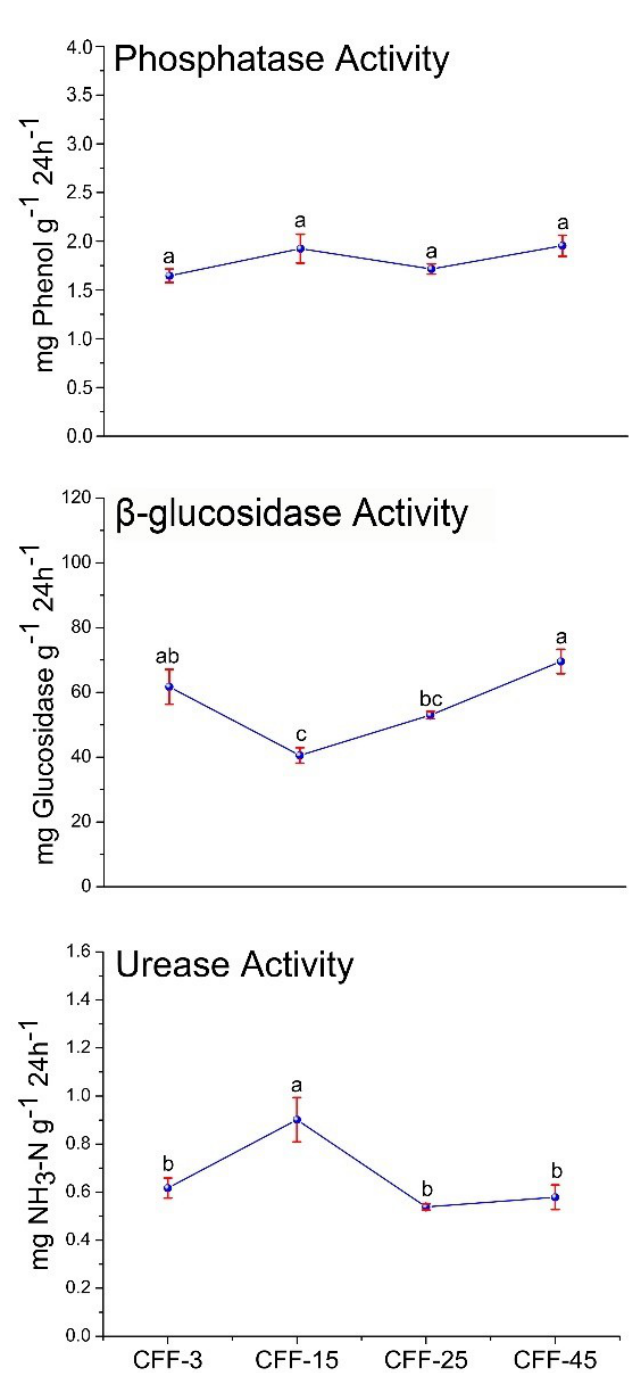
Figure 4. Soil enzyme activities under Chinese fir stands with di ff erent ages in Jiangxi Province. Values are means ( n = 3) with a bidirectional stand error bar. Via Duncan’s multiple comparison test, di ff erent letters in the same columns indicate significant di ff erence among ages. CFF-3, 3-year Chinese fir forests; CFF-15, 15-year Chinese fir forests; CFF-25, 25-year Chinese fir forests; CFF-45, 45-year Chinese fir forests.